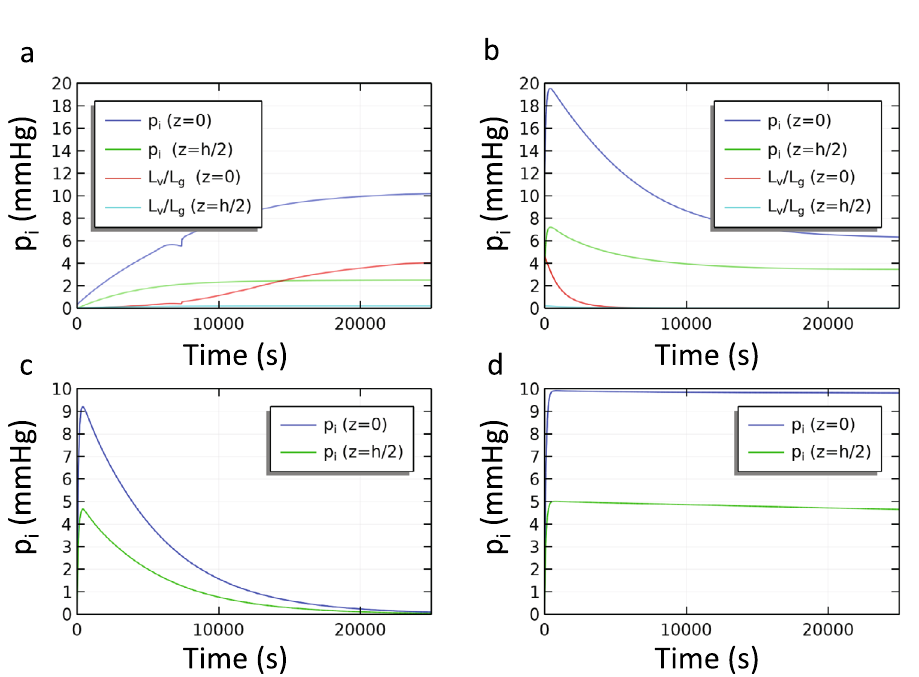
Figure 7. Transient single-layer model with baseline parameters. The IFP is shown at the ankle level (z = 0) and at the top of the wrap (z = h/2). ( a ) No wrap is yet present. The initial condition is the steady solution with constant capillary pressure from Fig. 3a (p c = 10 mmHg). At t = 0 venous insufficiency begins. The final condition is that in Fig. 4a. ( b ) A compression wrap (0 < z < h/2) is applied gradually during the first 100 s to the final condition from ( a ). The final condition in ( b ) is shown in Fig. 4b. ( c ) Single-layer model without gravity with baseline vascular interactions and ( d ) without gravity and without vascular interactions ( β c = β L = 0 ). Values for L v / L g remain low throughout for panels c and d